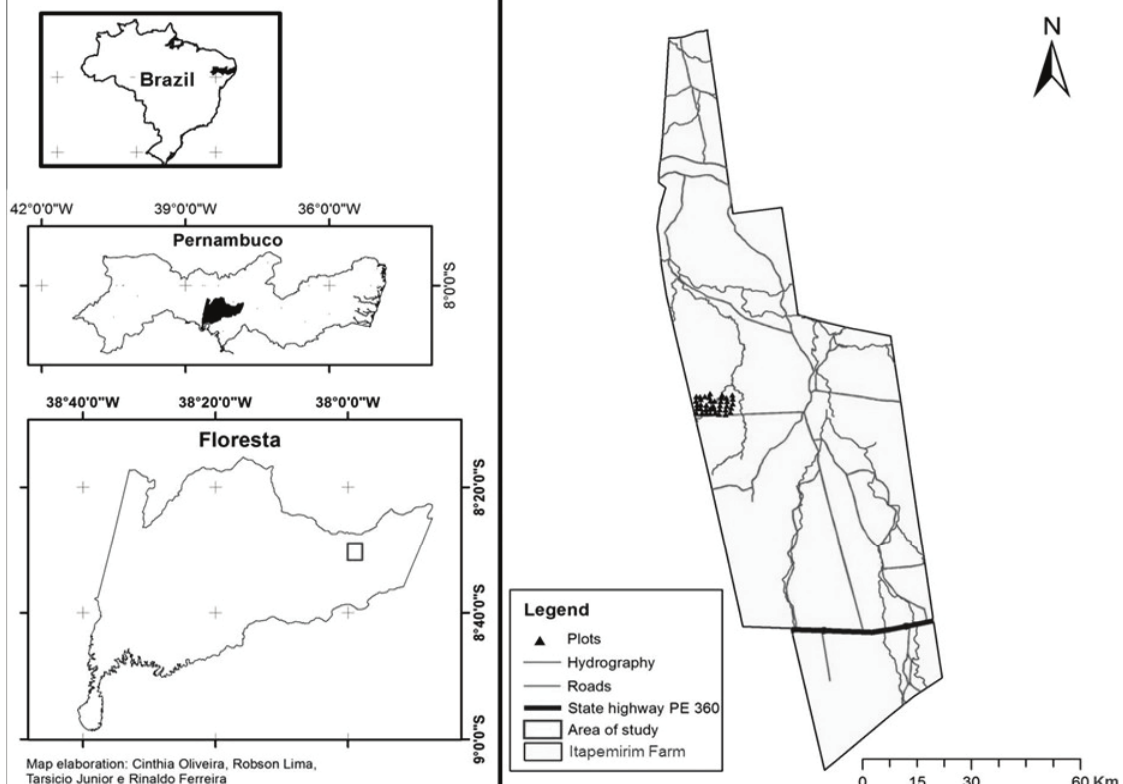
figure 1 – Study site: inside details and location from the wider to specific